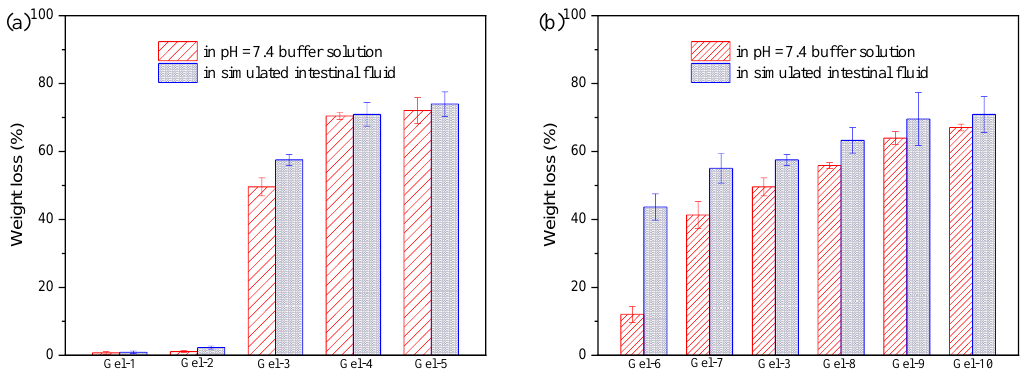
Figure 10. The weight loss of P(AAc- co -Am)/PVA double network hydrogels after 10 days of degradation in phosphate buffer solution (pH = 7.4, I = 0.1) and the simulated intestinal fluid: ( a ) hydrogels with various Am/AAc ratios; ( b ) hydrogels with various Fe 3+ concentrations.